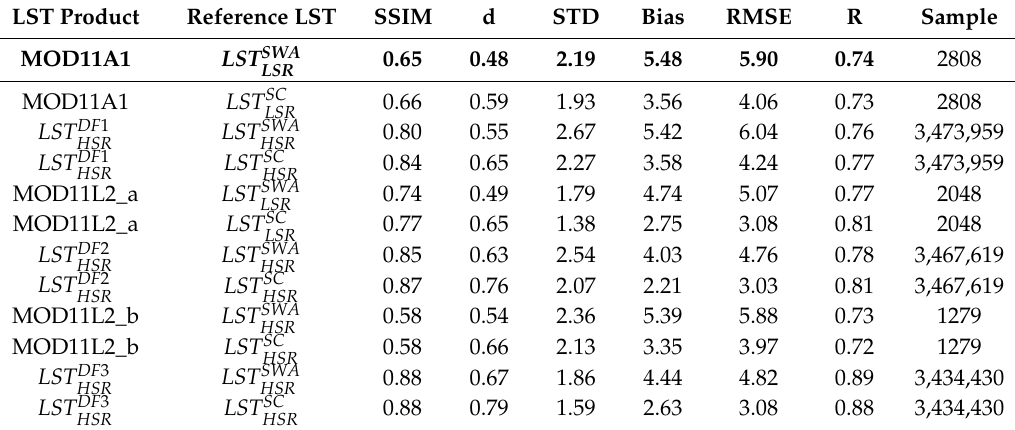
Table 3. The comparison results of the fused LSTs and MODIS LSTs with reference LSTs in Case 2.